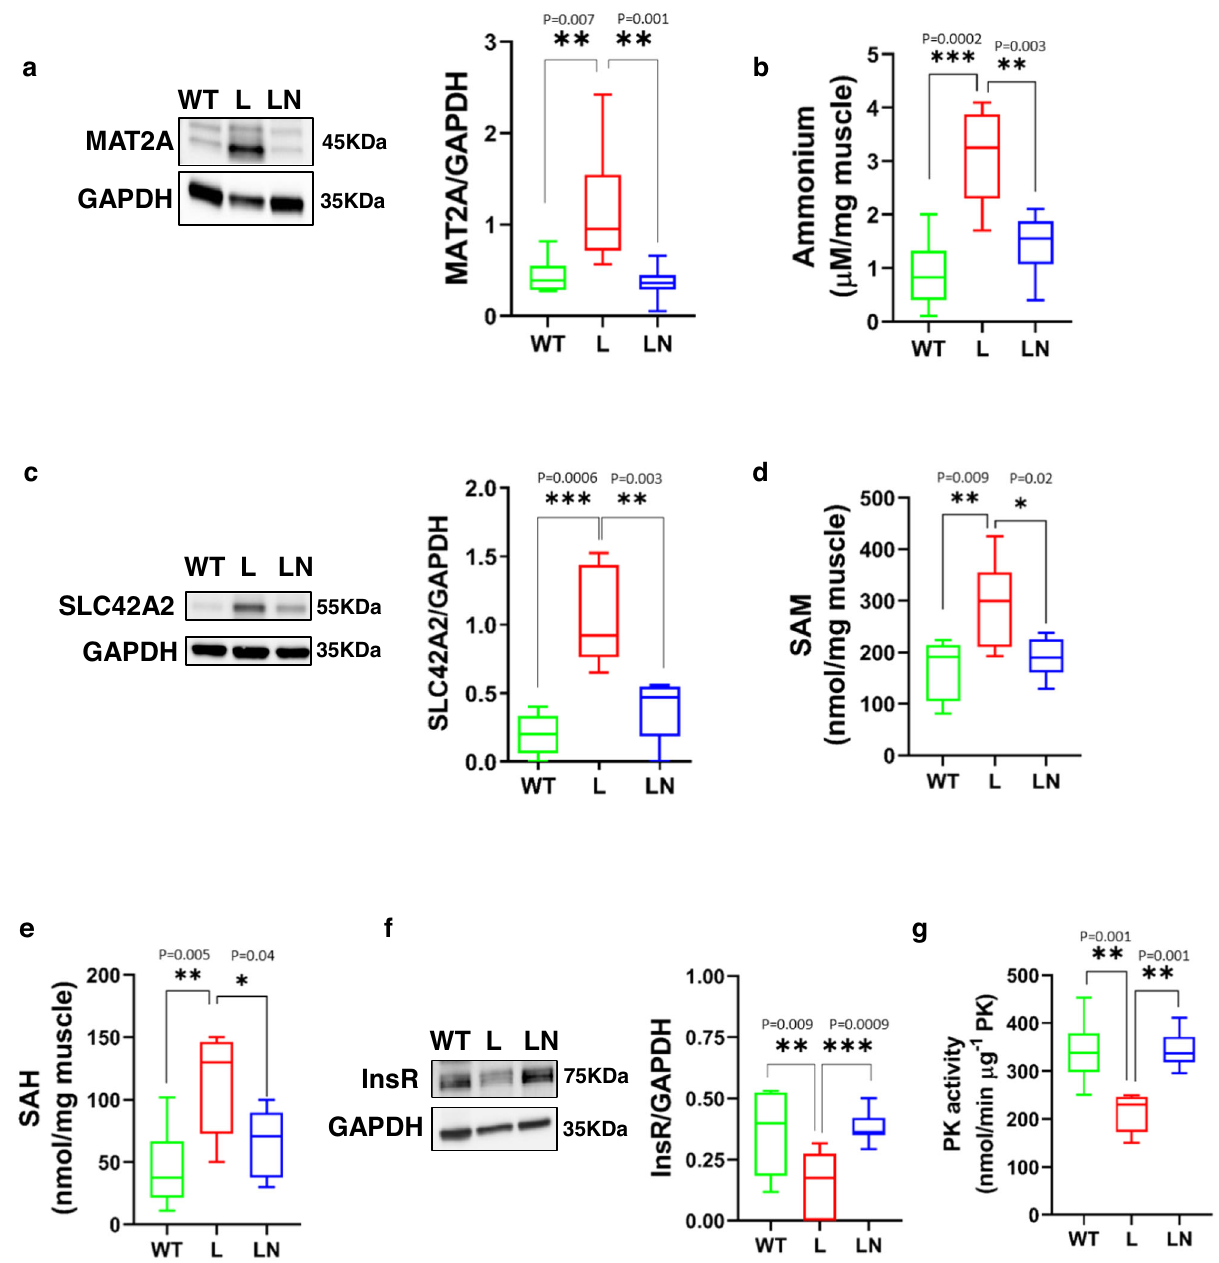
Fig.6|NANOGrestoresmarkersofmethioninecatabolismandglycolysisinthe TA muscle of LAKI mice. Elvax (100 μ l) loaded with Dox (25mg) was implanted around the right TA muscle of LAKI mice to induce NANOG expression, while the left limb served as an internal control (Elvax, no Dox). Two weeks later, the Elvax was removed and the TA muscle was evaluated 3 weeks later. a Western blot and band quanti fi cation for MAT2A; GAPDH served as loading control b Ammonium levels. c Western blot and band quanti fi cation for SLC42A2; GAPDH served as loading control. d , e Effect of NANOG on s -adenosyl methionine (SAM) and s -